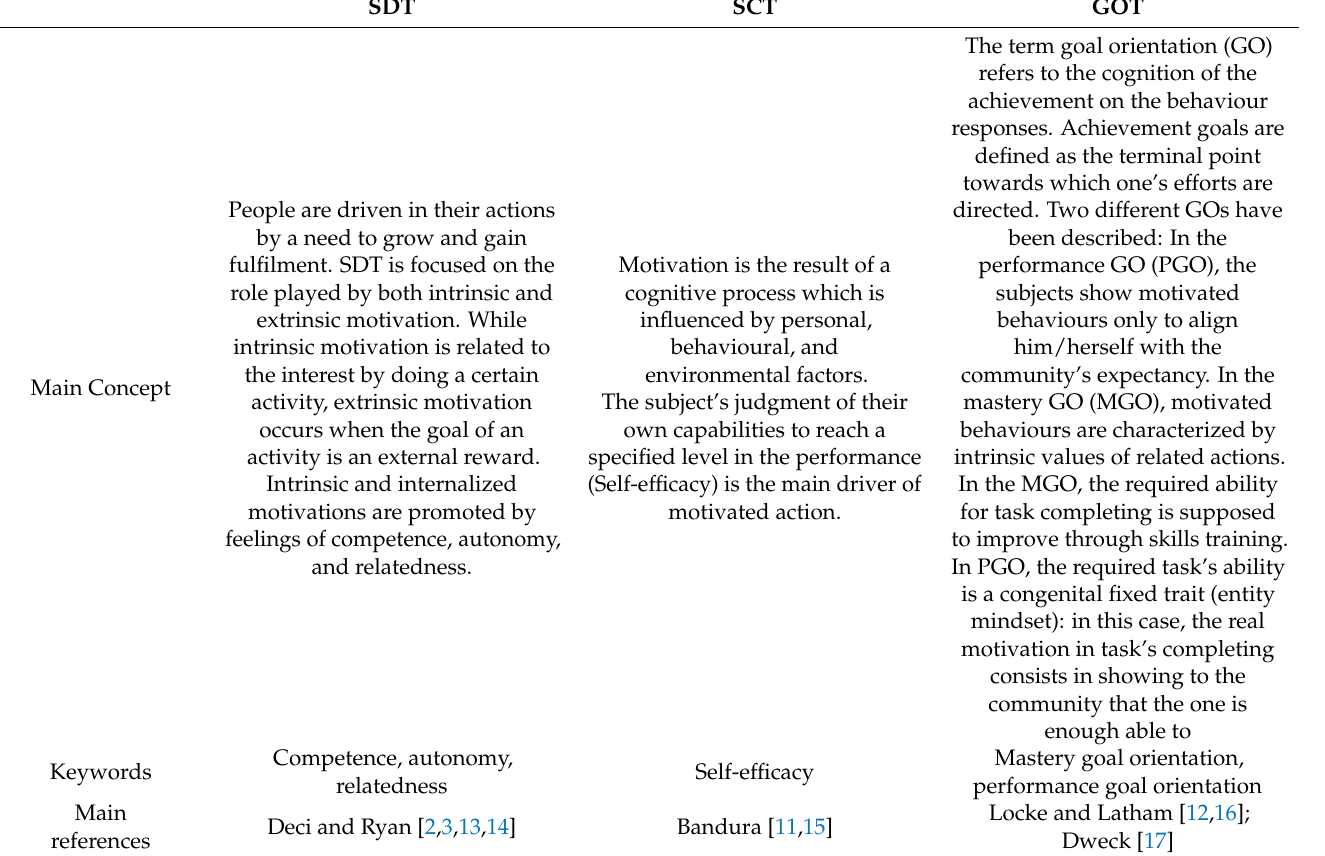
Table 1. Summary of contemporary motivation